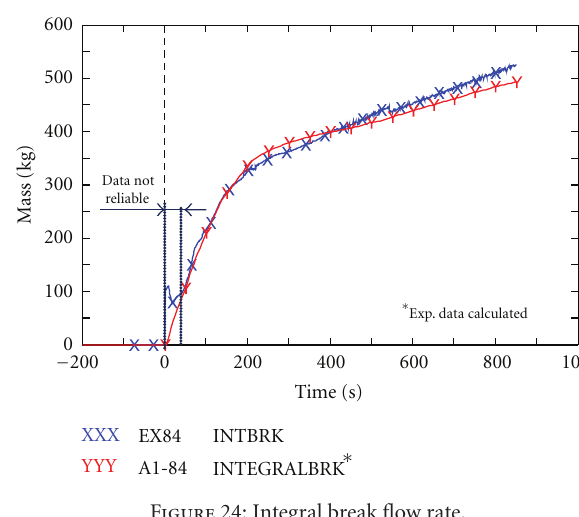
Figure 21: Secondary system pressure.